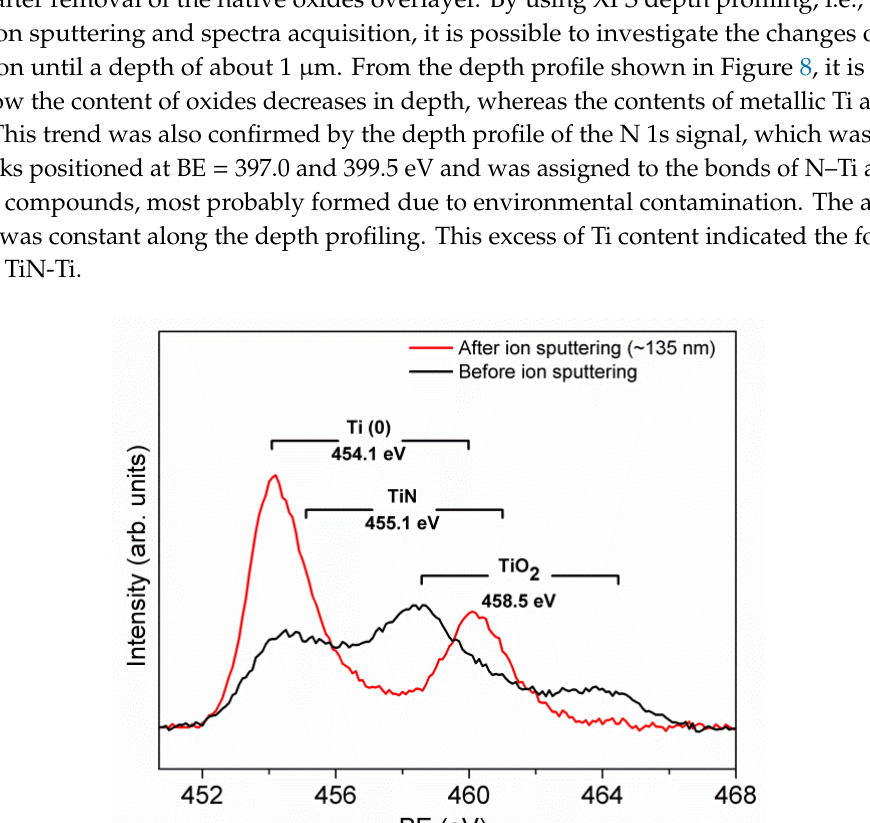
Figure 6. Ti 2p peak fitting of the Ti/TiN composite coating [19].